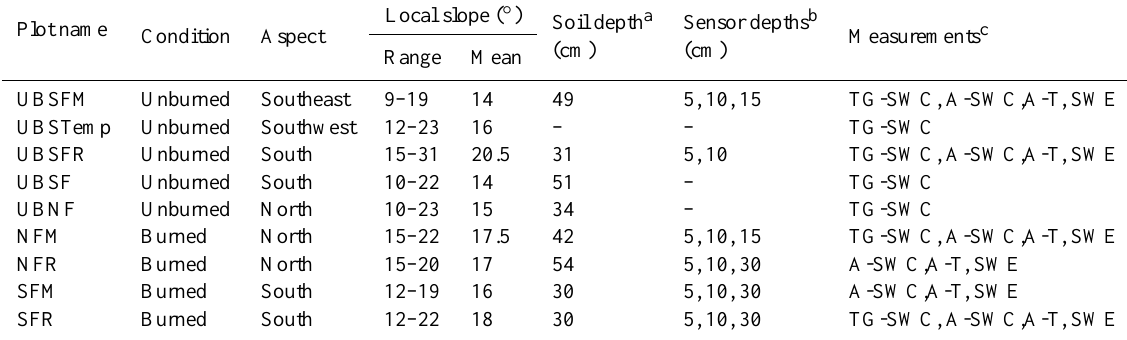
Table 1. Experimental plot